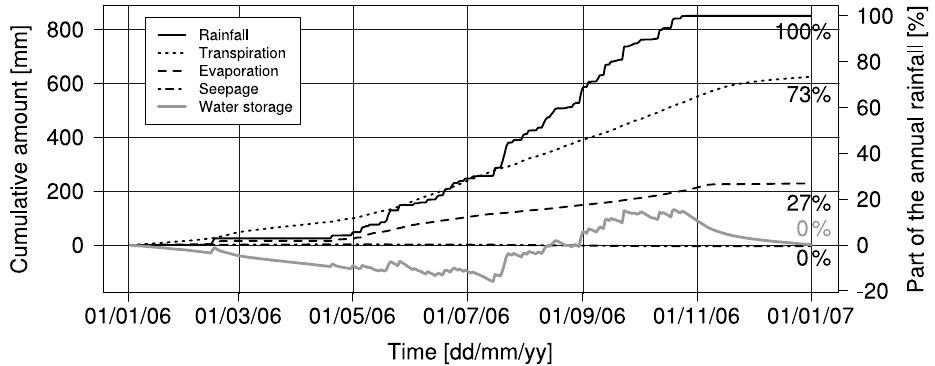
Fig. 8. Synthetic annual water balance of the hillslope: rainfall, transpiration, evaporation, seepage and water storage. All terms are simulated except the rainfall, which is measured. Seepage is close to zero all year long. Table 4. Summary of the annual output fluxes of the virtual experiment simulations. Presence of riparian forest Absence of riparian forest value rainfall